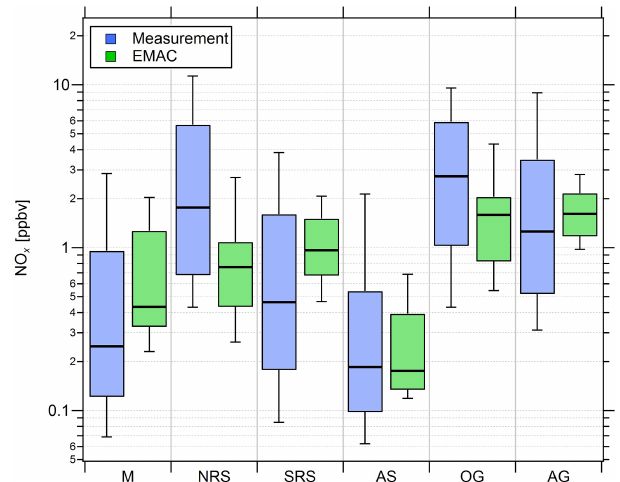
Figure 4. Comparison of measured (blue) and simulated (green) NO x mixing ratios in the six different regions investigated during AQABA. The horizontal black bar indicates the median value, the box shows the 25th and 75th percentiles, and the whiskers show the 10th and 90th percentiles.